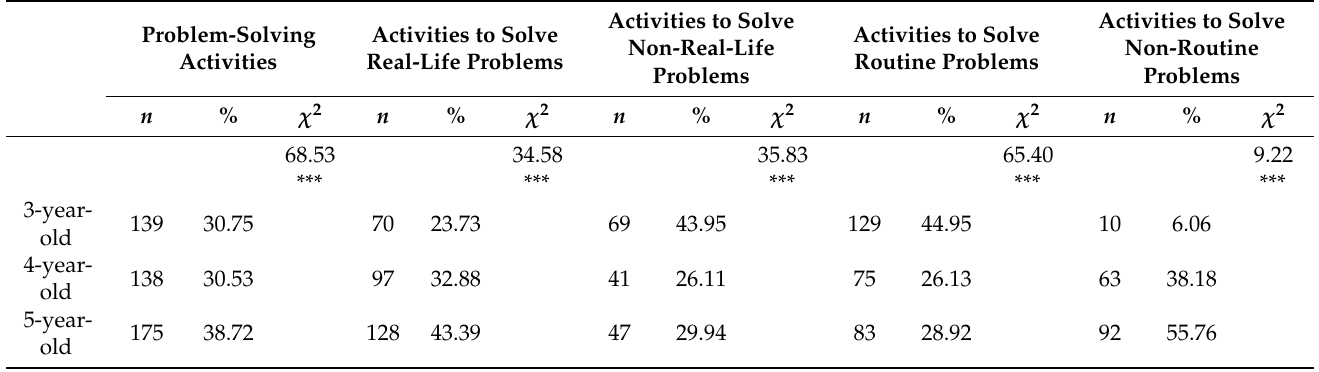
Table 4. The distribution of problem-solving related mathematics activities across all age